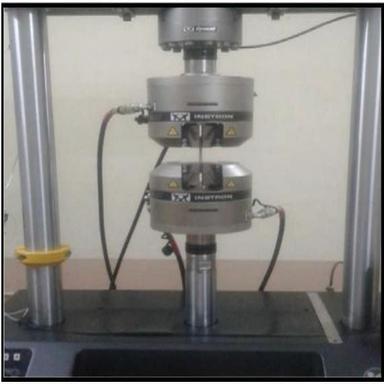
Fatigue testing of 31% sample.